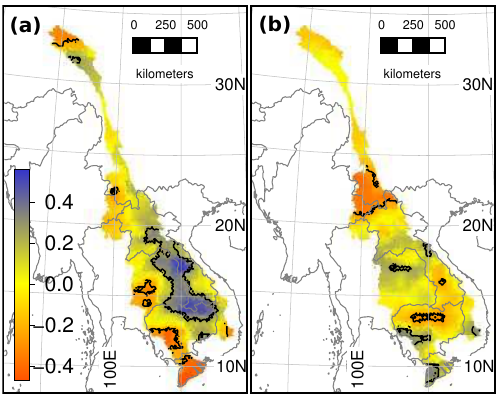
Fig. 5. Pearson correlation between GPCC precipitation over the Mekong basin and (a) WNPMI and (b) ISMI. Regions where the statistical significance was greater that 95% are enclosed by a black contour line.